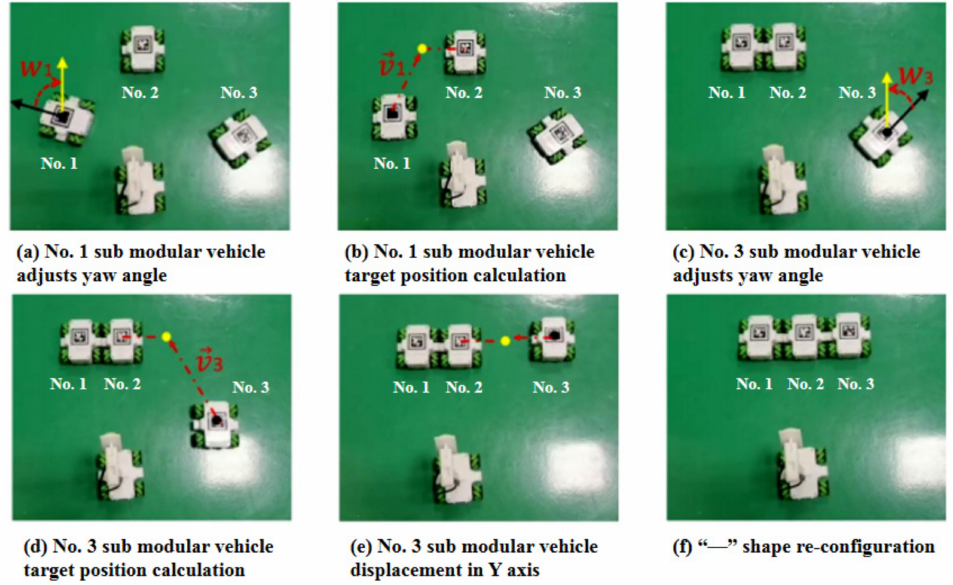
Figure 23. “—” shape reconfiguration